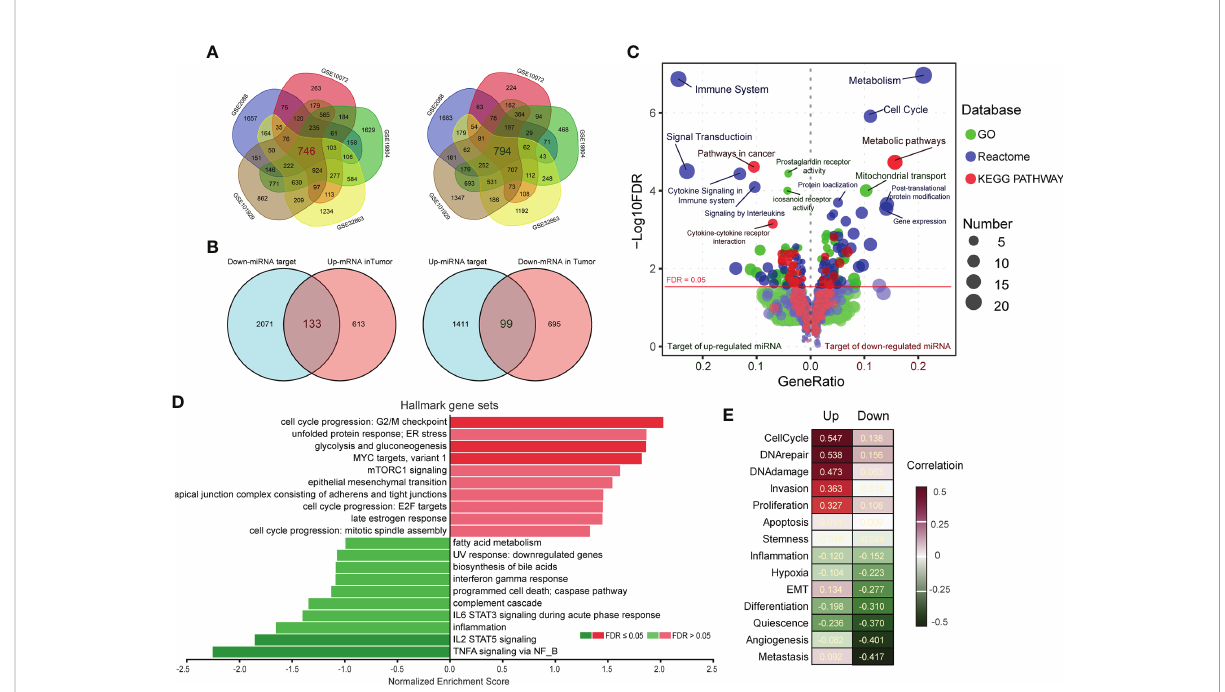
FIGURE 2 Functional enrichment of target genes of miRNAs. (A) Up- and down-regulated genes ( p < 0.01) in tumors compared to normal were obtained by GEO2R analysis, and the overlapping parts of the fi ve LC datasets were selected as candidate target genes of miRNAs. (B) Comparing the miRNA target genes list predicted by ENCORI with the merged dysregulated genes list of fi ve LC datasets, the overlapping parts were considered to be the targets of miRNAs. (C) The GO (green), Reactome (blue) and KEGG pathway (red) enrichment analysis of miRNA target genes was performed by KOBAS 3.0. The size of the knots represents the number of enriched genes. (D) The target genes were ranked by the mean of log2FC in the fi ve LC datasets, and were annotated by Gene Set Enrichment Analysis (GSEA) according to Hallmark gene sets of cancer. (E) Functional states of target genes in LC were analyzed by CancerSEA, and the red/green scale boxes represent up- or